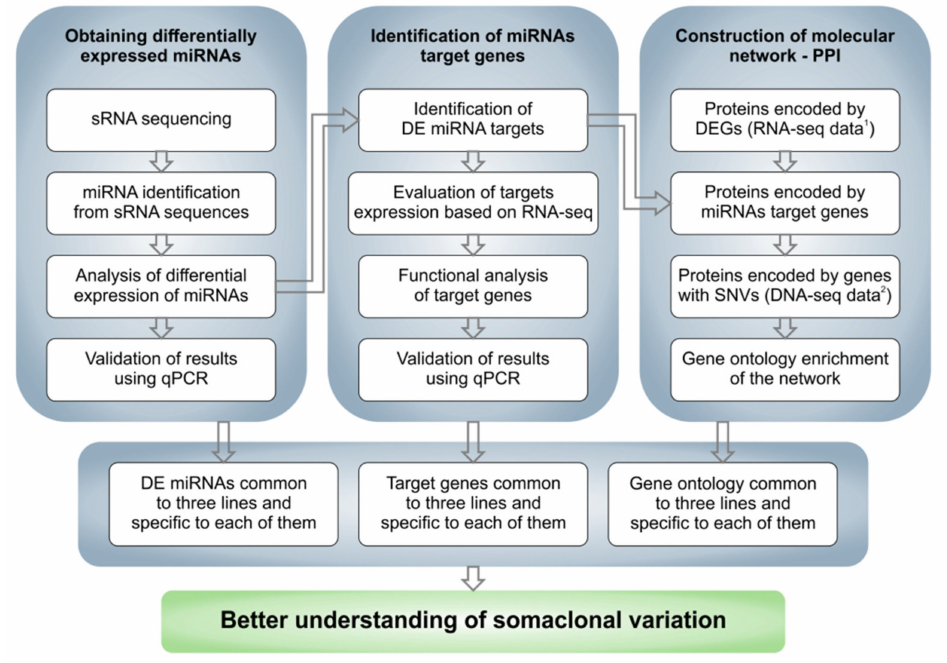
Figure 1. Overall scheme of the performed analysis. 1 RNA-seq data come from Pawełkowicz et al., 2021 [41]; 2 DNA-seq data come from Skarzy´nska et al., 2020